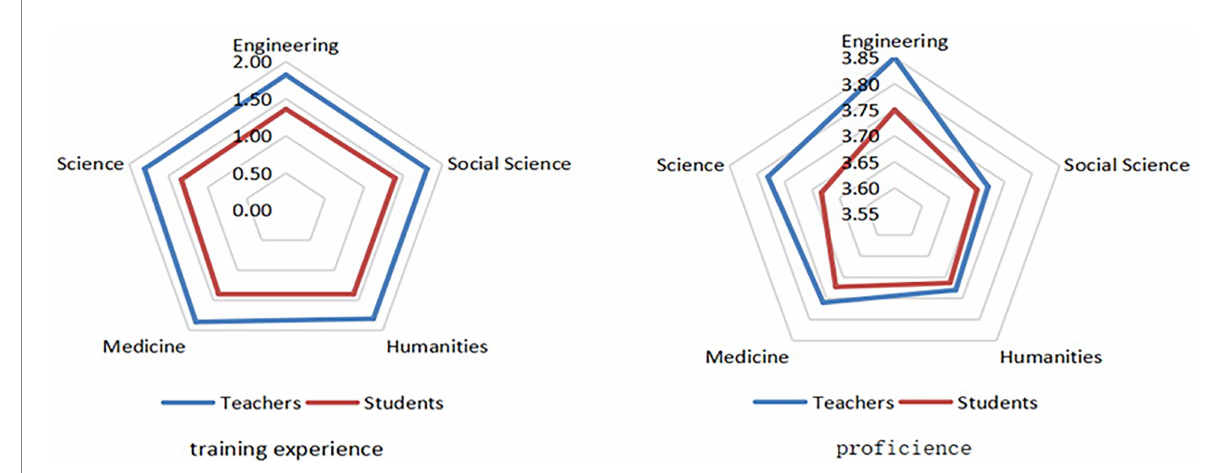
FIGURE 2 Training experience and proficiency level of online education reported by teachers and students of different